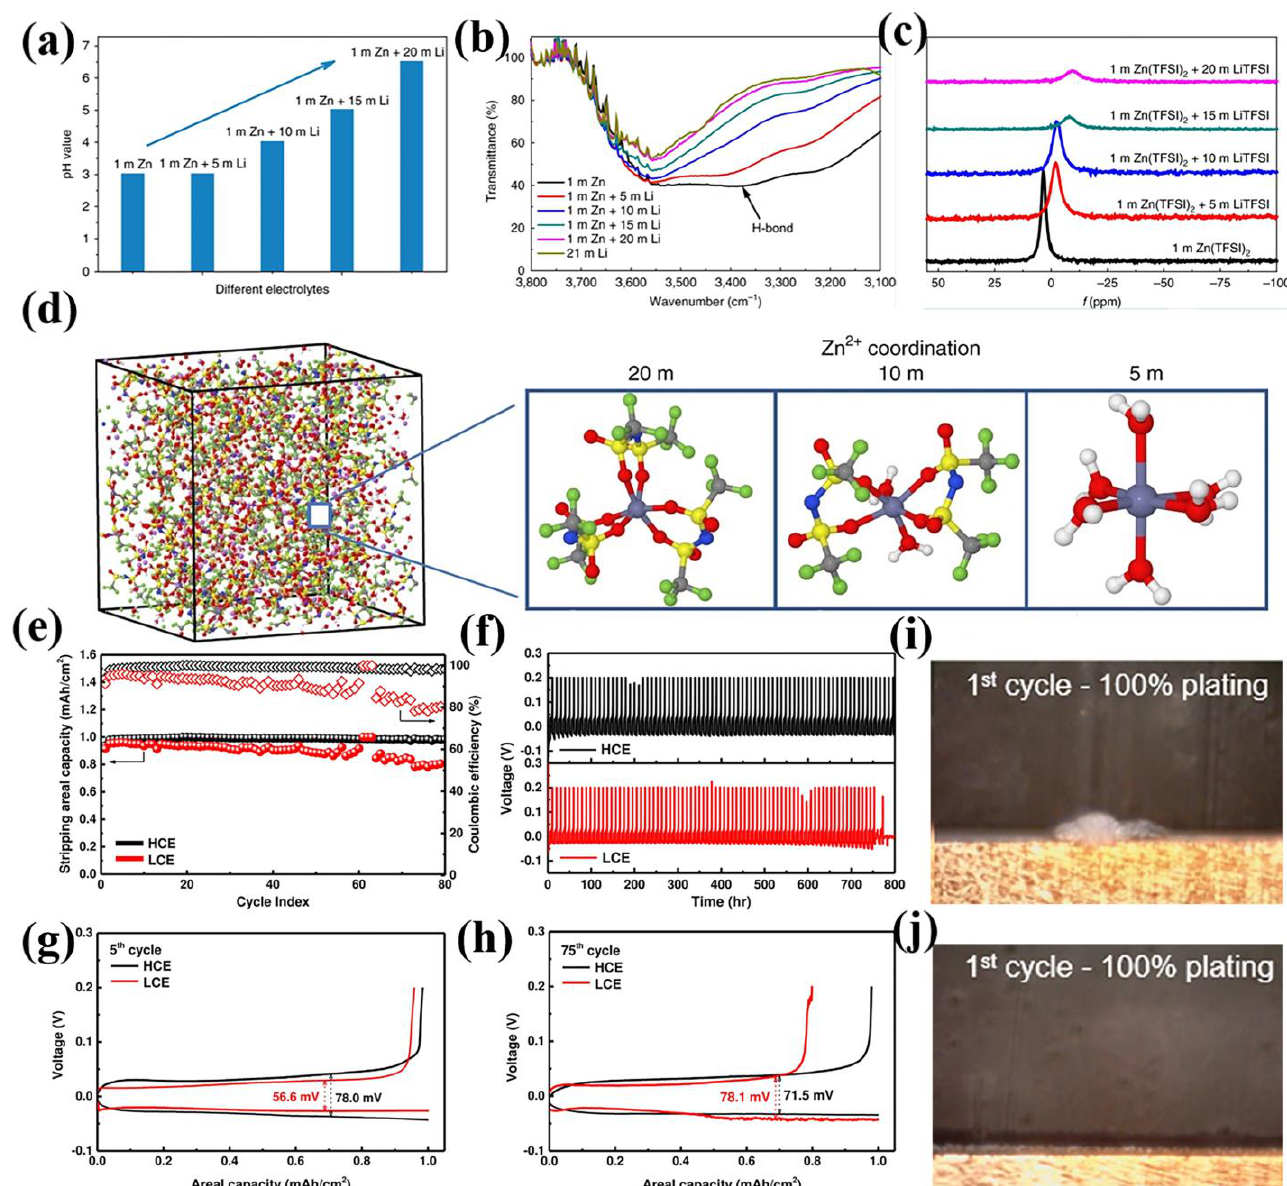
Figure 4. Effect of LiTFSI concentration on the structure of cationic solvation sheaths. ( a ) The pH values of the electrolytes with varying LiTFSI concentrations. ( b ) FTIR spectra with varying LiTFSI concentration between 3800 and 3100 cm −1 . ( c ) The change with salt concentration of chemical shifts for 17 O nuclei in solvent (water). Adapted with permission from Ref. [15]. Copyright 2018 Nature Materials. ( d ) Schematic of Zn 2+ − solvation structure. Cycling performance of the Zn||Cu half − cell at a current density of 0.2 mA cm −2 , 1 mAh cm −2 . ( e ) Stripping capacity and coulombic efficiency. (f) Galvanostatic plating/stripping of zinc, and voltage profile at the ( g ) 5th cycle and ( h ) 75th cycle. Snapshots of in operando OM in the Zn||Cu half-cell at a current density of 1 mA cm − 2 , 1 mAh cm − 2 using ( i ) LCE and ( j ) HCE. Adapted with permission from Ref. [57]. Copyright 2022 American Chemical